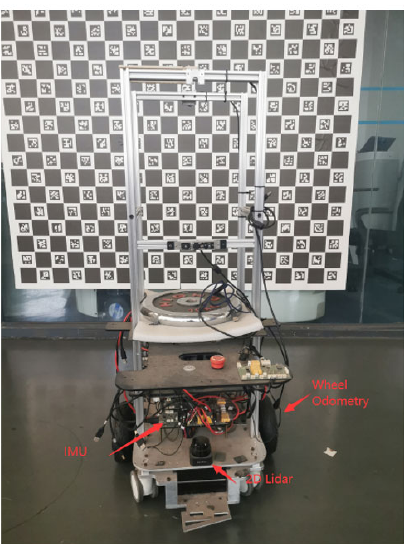
Fig. 11 Test platform. The test platform is equipped with three types of sensors: 2D lidar, wheel odometry, and